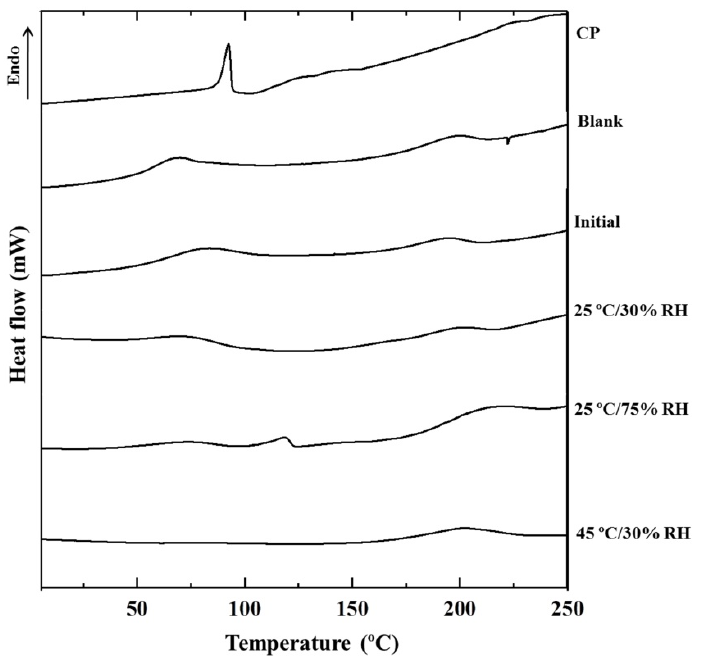
Figure 6. Differential scanning calorimetry (DSC) thermograms of CP-F after storage at various conditions for 12 months, in comparison to the initial CP-F, CP, and blank nanofibrous film (blank).